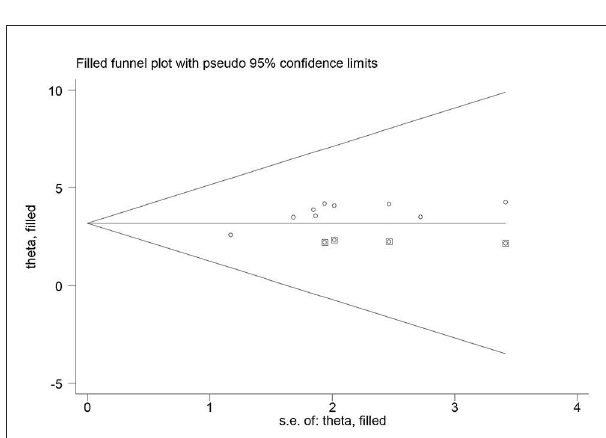
FIGURE12 Trim and fill analysis for the prevalence of favorable attitude toward